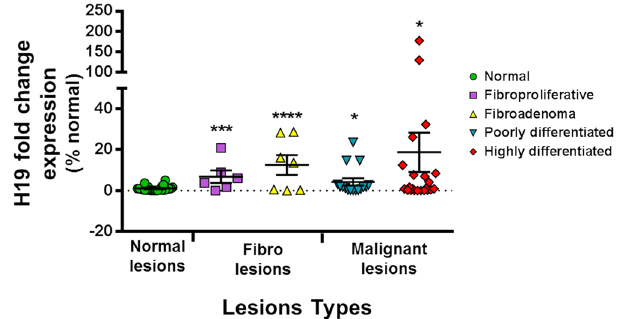
Figure 1. H19 levels are higher with malignancy degree. On a total of 79 biopsies, H19 fold change expressions were progressively higher in fibroproliferative lesions (6.9 ± 3.07), fibroadenoma lesions (12.5 ± 4.8) poorly differentiated lesions (4.3 ± 1.73) and highly differentiated lesions (18.8 ± 9.6) compared to normal lesions. Expression levels were normalized to GAPDH expression. Results were expressed as means ± SEM. ANOVA and t-test, *p < 0.05, ***p < 0.001, ****p <